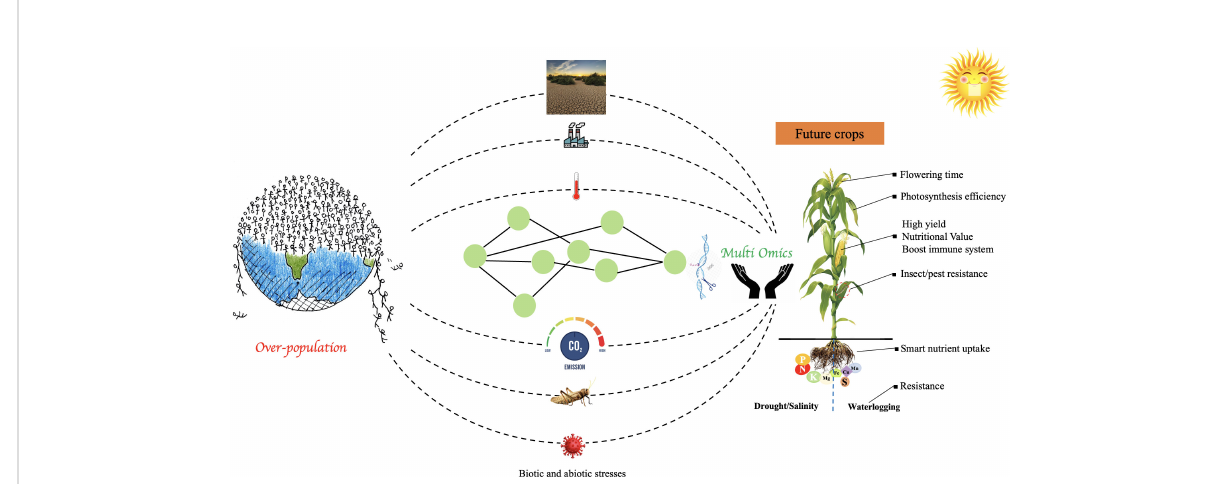
FIGURE 3 Schematic representation of the importance of integrated omics techniques in accelerating the development of future crops to feed the exponentially growing population. The development of climate-resilient and nutrient-rich crops is facilitated by integrated multi-omics approaches paired with genetics approaches, improved plant breeding, gene editing, and computational modeling techniques in a systems biology